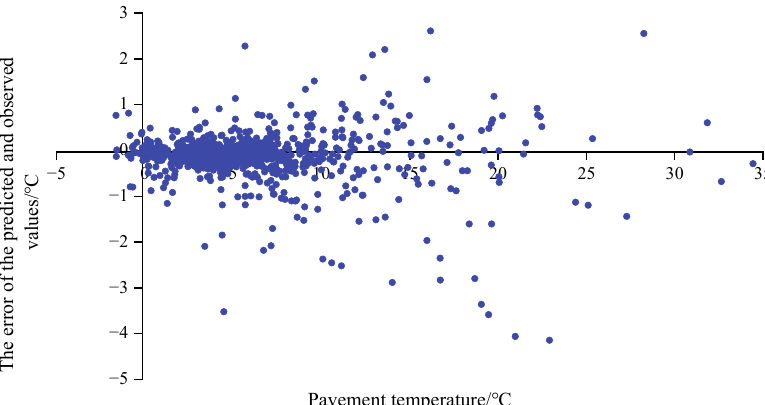
Figure 14. Distribution of errors.